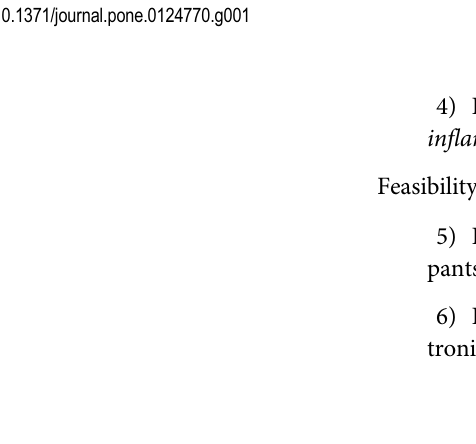
Fig 1. Definition of escalation of